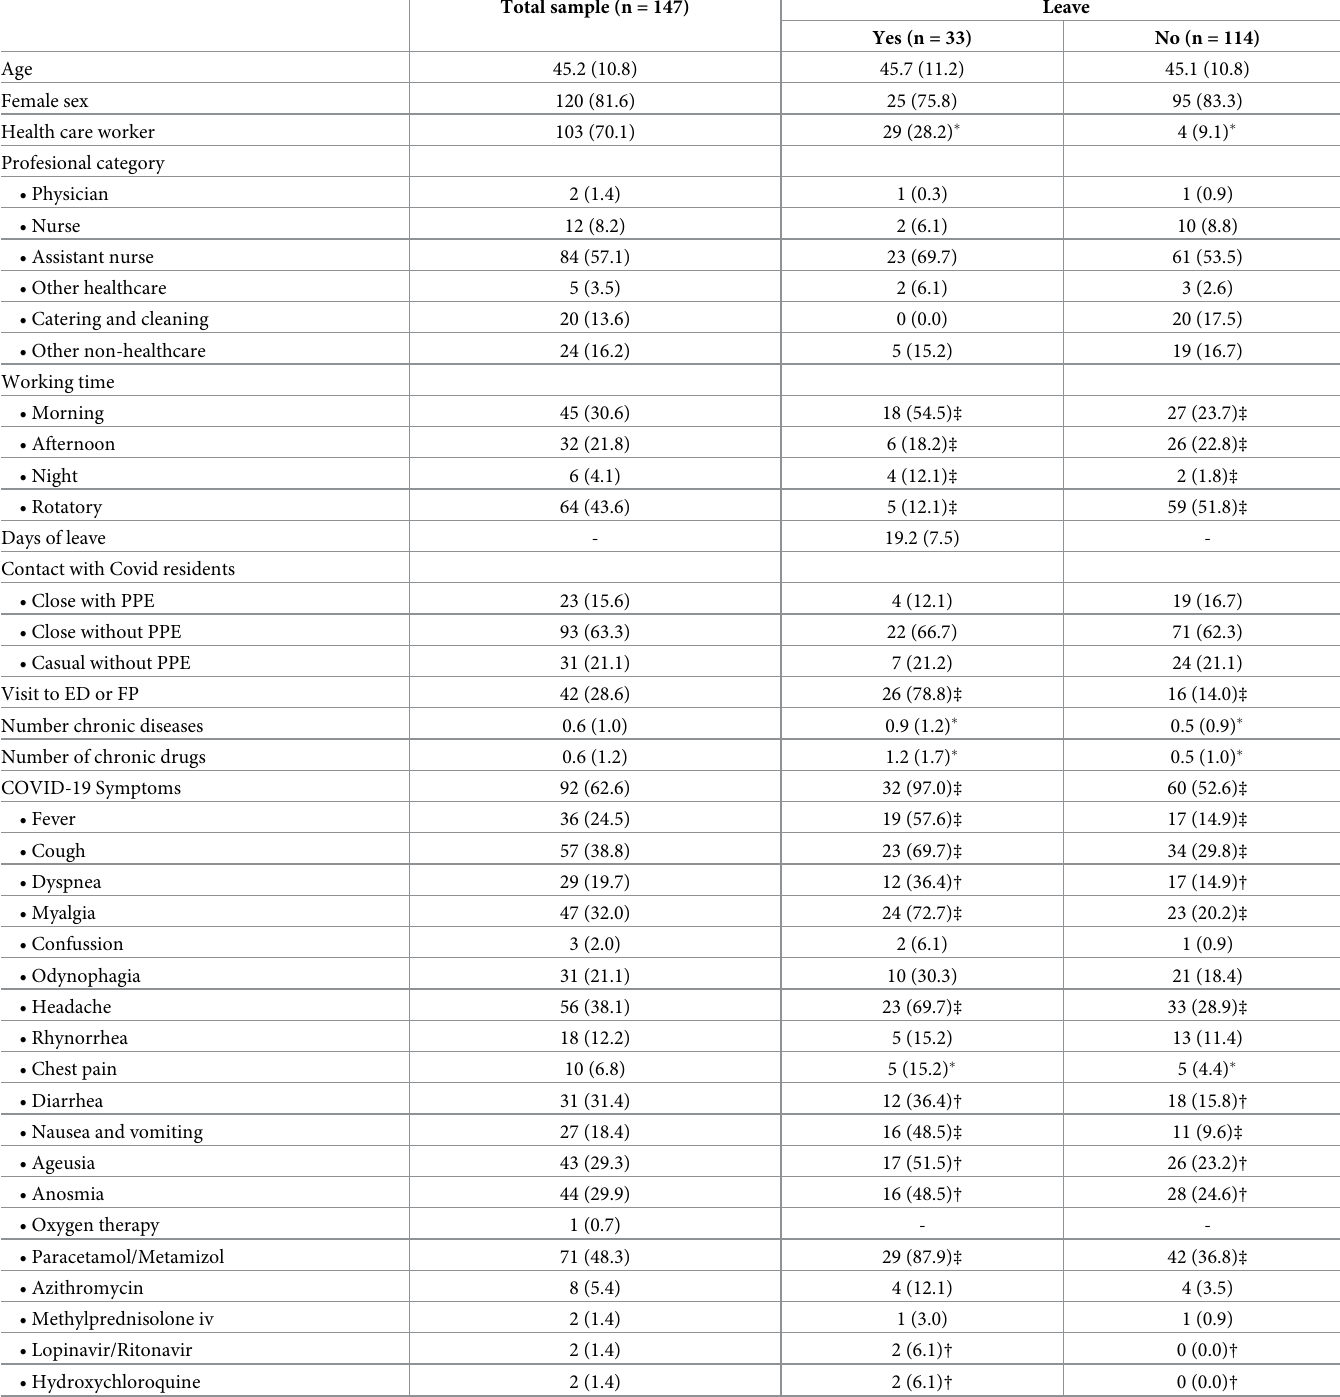
Table 3. Clinical characteristics of 147 workers contacted in facility